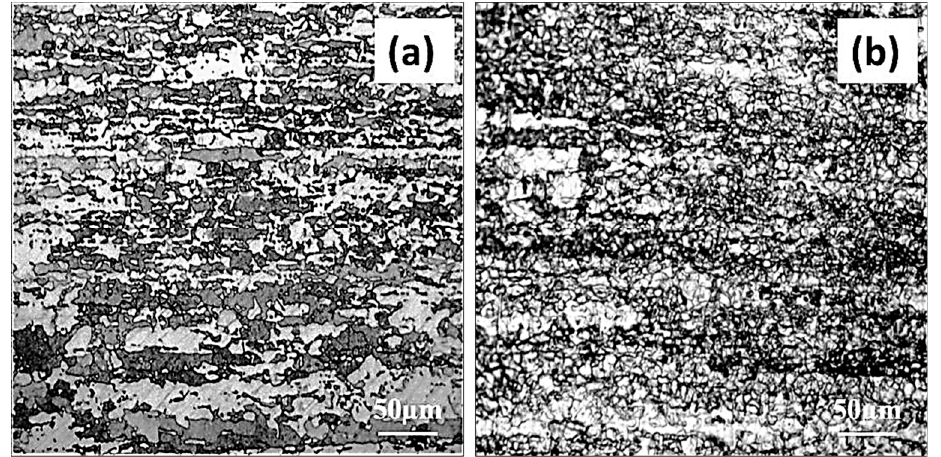
Figure 5. Metallographic images of 2205 DSS ( a ) before and ( b ) after 4 h of corrosion in 0.137 mol/L HCl + 0.385 mmol/L Na 2 S solution, corrosion product was removed.